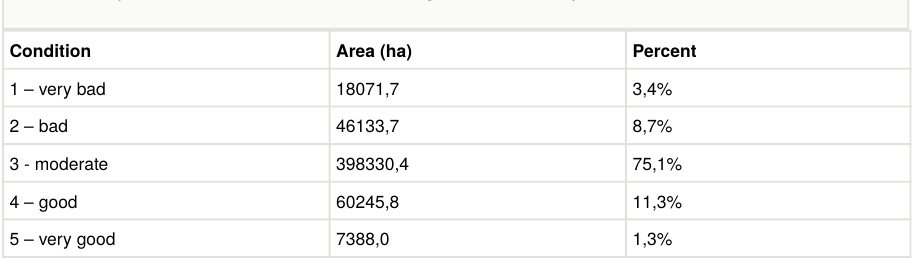
Urban ecosystems condition based on the integrated index of spatial